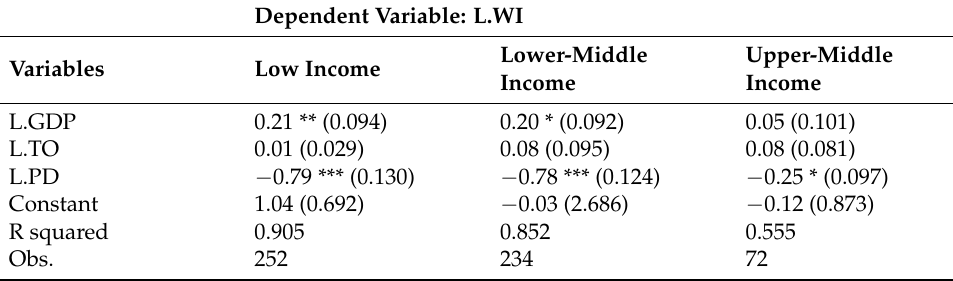
Table 4. Estimation results of the drivers of water infrastructure performance by income levels. Dependent Variable: